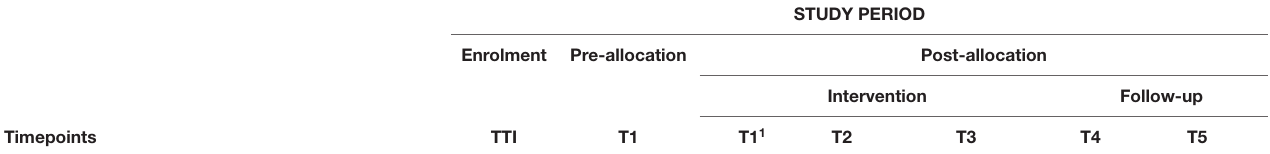
TABLE 2 | Schedule of enrollment, interventions, and assessments of participants in the RePlay study that explores gross motor function in children aged 1–5 years during intensive cancer treatment. STUDY PERIOD Enrolment